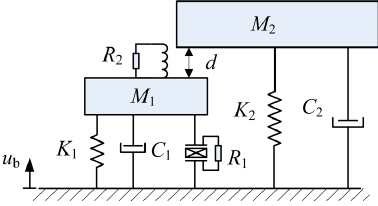
Figure 2. Lumped parameter model of the FUCHEH.